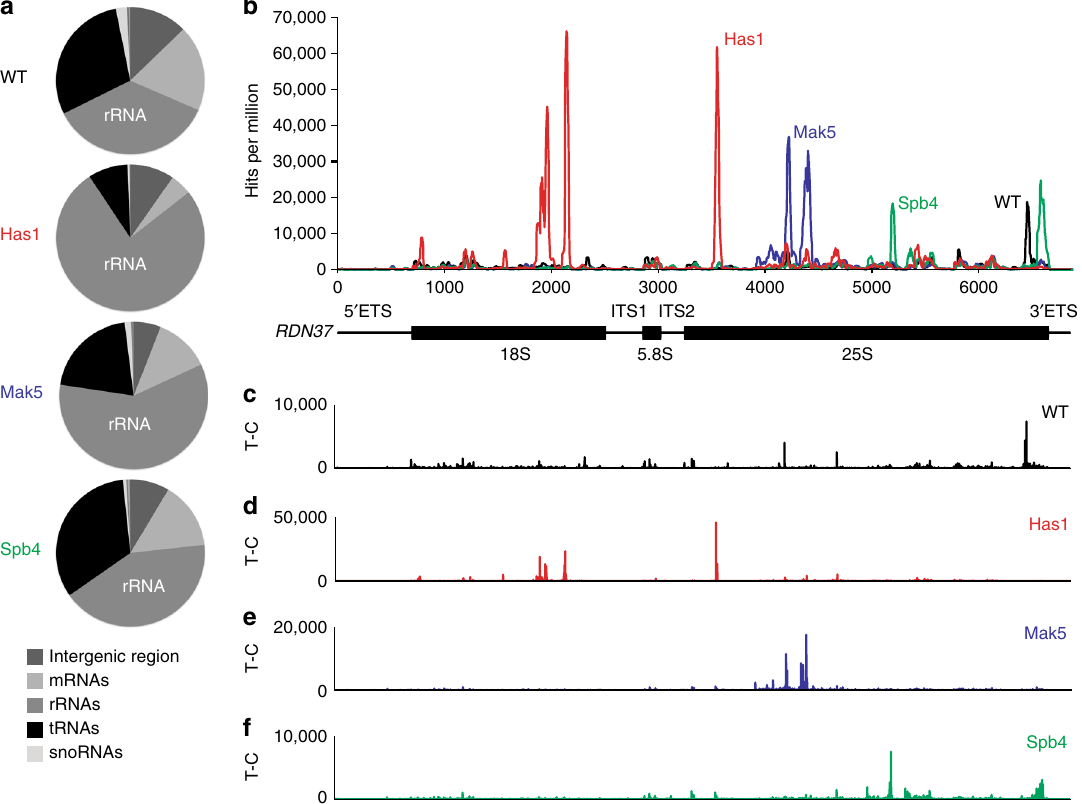
Fig. 3 Has1, Mak5 and Spb4 crosslink to spatially distinct pre-rRNA sequences. a Wild-type yeast (WT) or yeast expressing C-terminally HTP tagged Has1, Spb4 or Mak5 were subjected to PAR-CRAC and the obtained sequence reads were mapped to the S. cerevisiae genome. The relative proportions of reads mapping to different classes of RNAs is shown. b For WT, Has1-HTP, Mak5-HTP and Spb4-HTP, the normalised number of reads mapped per nucleotide to the RDN37 locus is shown above a schematic view of the initial 35S pre-rRNA transcript. Nucleotide positions on the 35S pre-rRNA transcript are indicated below the graph. c – f The number of T-C mutations detected per nucleotide of the RDN37 locus is shown for the WT ( c ), Has1-HTP ( d ), Mak5-HTP ( e ) and Spb4-HTP ( f ) CRAC samples. ETS external transcribed spacer, ITS internal transcribed